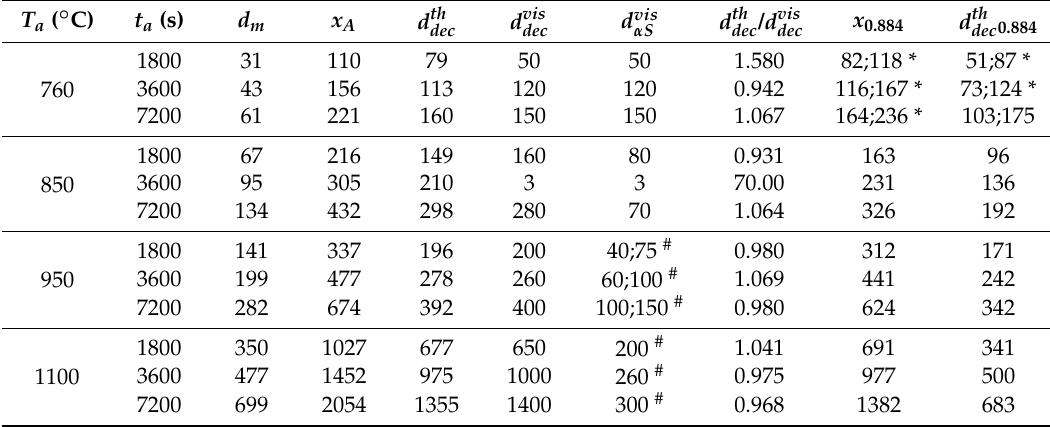
Table 2. Calculated and measured maximum thicknesses of decarburized